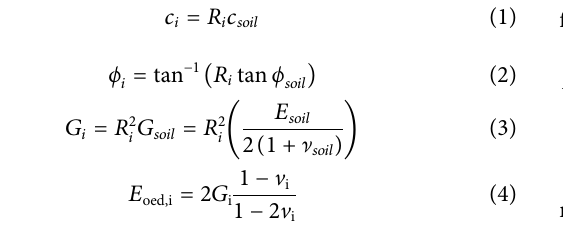
Frontiers in Built Environment |